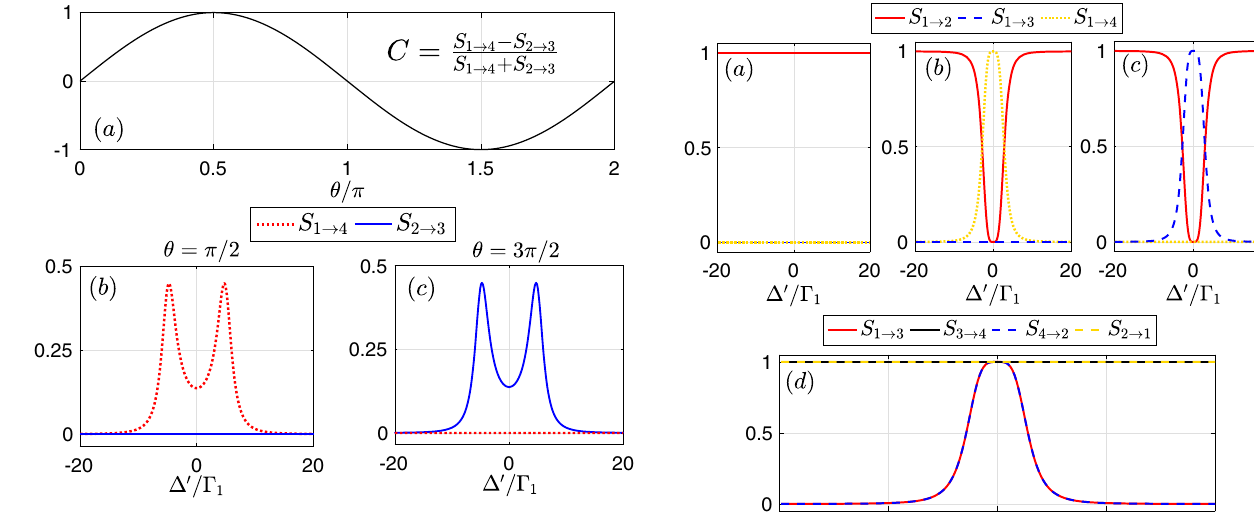
Fig. 7b, c. Note that C = 1 ( C = − 1) corresponding to θ = π / 2( θ = 3 π /2), implies that only the scattering from port 2 (1) to